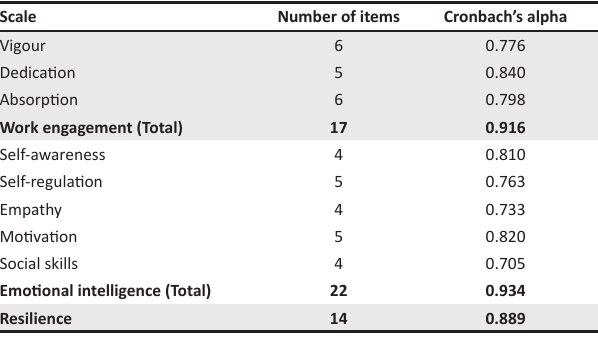
TABLE 1: Reliability estimates for the work engagement, emotional intelligence and resilience